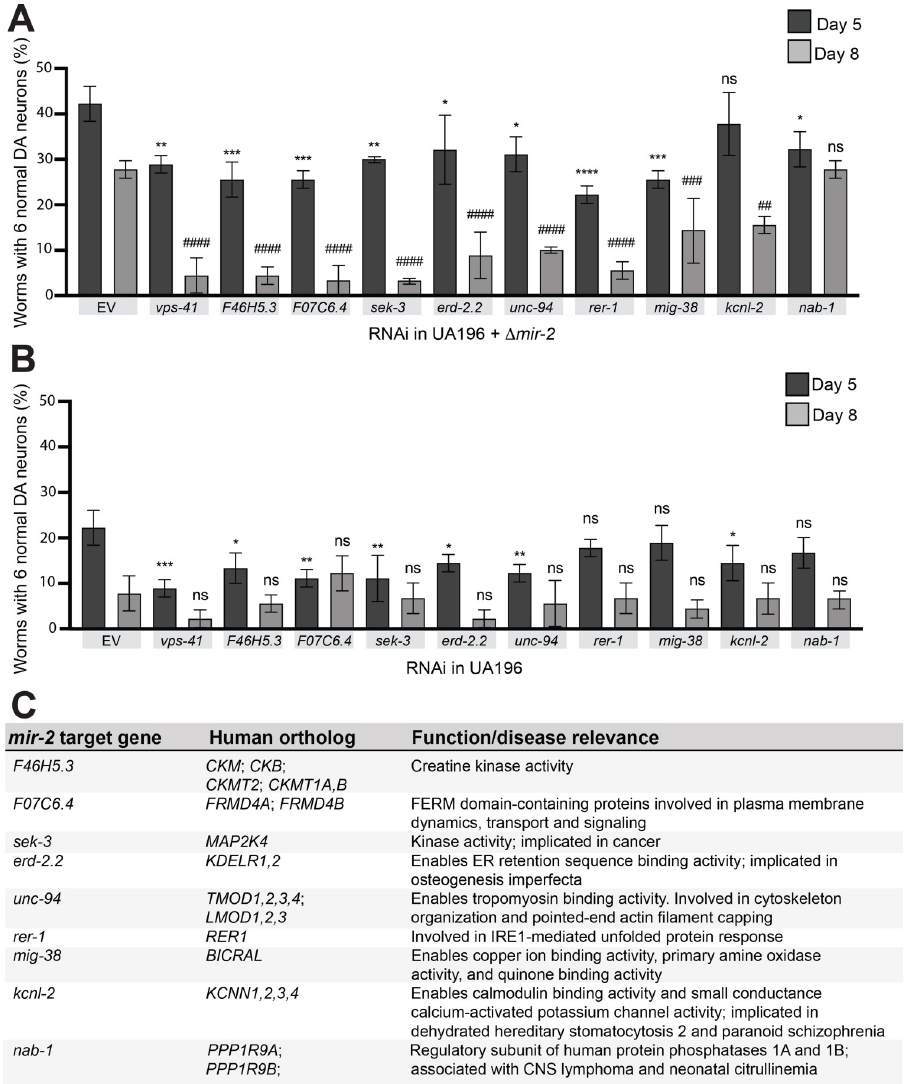
Fig 4. Modulating mir-2 -dependent suppression of target gene expression levels alters α -syn-induced DA neurodegeneration. ( A, B ) DA neurons were scored for degeneration on days 5 and 8 post-hatching. RNAi was performed in a RNAi sensitive α -syn model with a mir-2(gk259) mutant background ( A ) and in the RNAi sensitive α - syn model that is mir-2 wildtype ( B ). Nine validated targets of mir-2 that have human orthologs were knocked down, along with a positive control, vps-41 . Values represent mean + S.D. (n = 30 worms per genotype per replicate, 3 independent replicates). One-Way ANOVA with Dunnett’s post hoc analysis was used to compare RNAi knockdowns to empty vector (EV) controls at day 5 and 8 post-hatching. For day 5 analyses, asterisks ( � ) above bars indicate comparisons of each individual knockdown to EV; ns P � 0.05, � P < 0.05, �� P < 0.01, ��� P < 0.001, ���� P < 0.0001. For day 8 analyses, pound signs (#) above bars indicate comparisons to EV; ns P � 0.05, ## P < 0.01, ### P < 0.001, #### P < 0.0001. ( C ) A list of the nine targets knocked down via RNAi in ( A ) and ( B ), their human orthologs, and